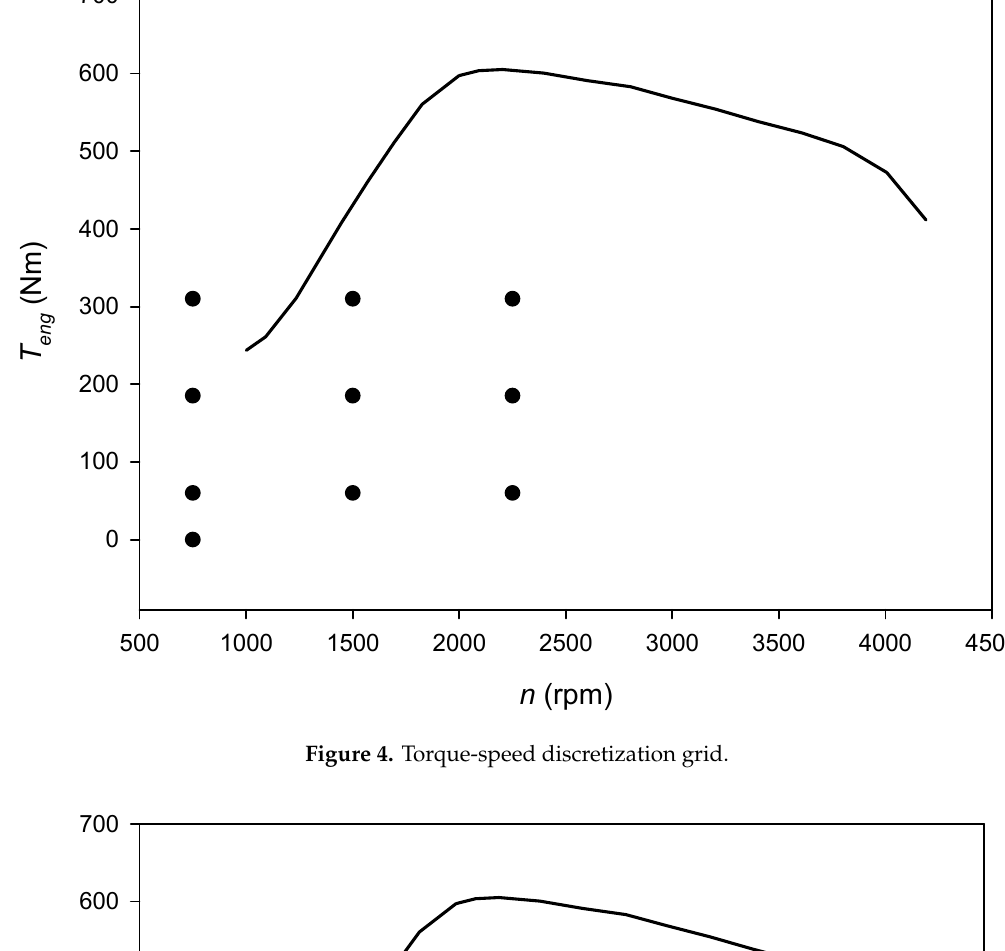
Figure 4. Torque-speed discretization grid.